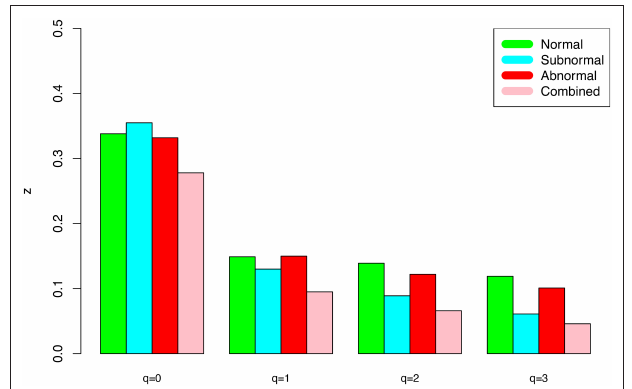
FIGURE 3 | The alpha-MAD profile ( D max - q series) for the semen microbiome alpha -diversity at the genus level, for normal, sub-normal, abnormal, and combined groups,